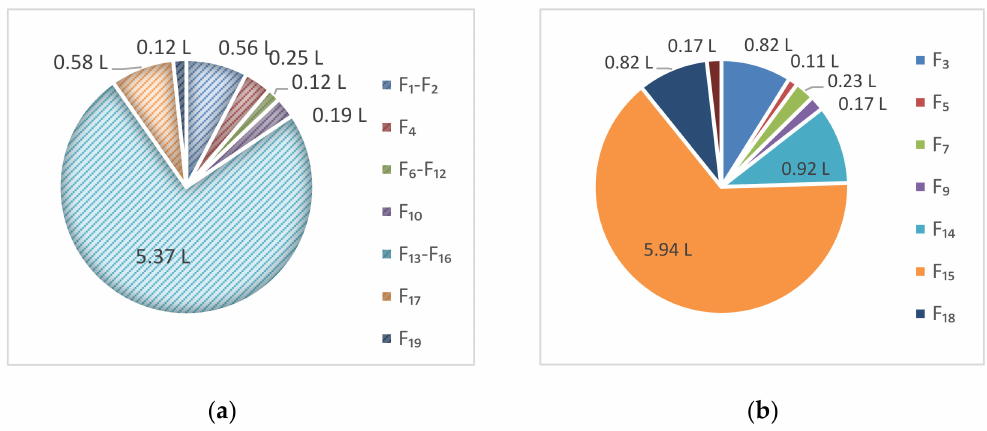
Figure 4. The direct water footprint of 1 L ethanol per production process. ( a ) Direct blue water footprint; ( b ) direct gray water footprint.